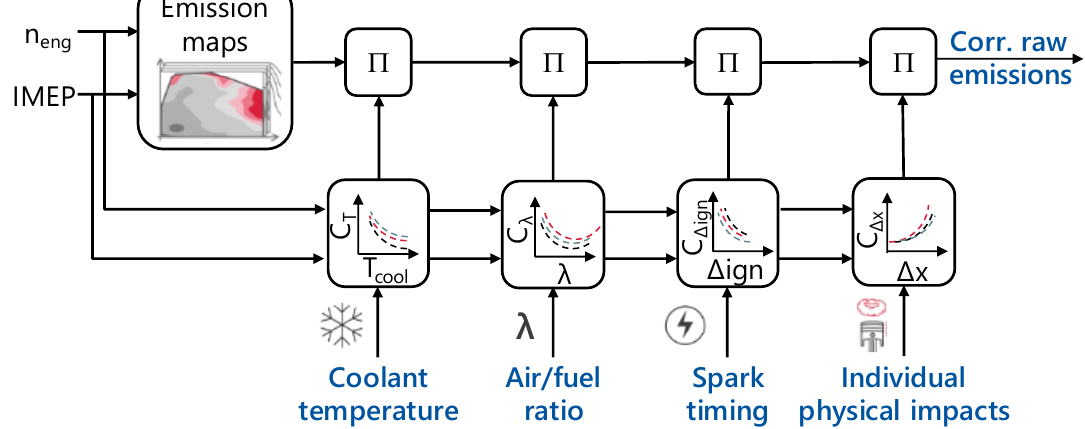
Figure 1. Structure of the raw emission